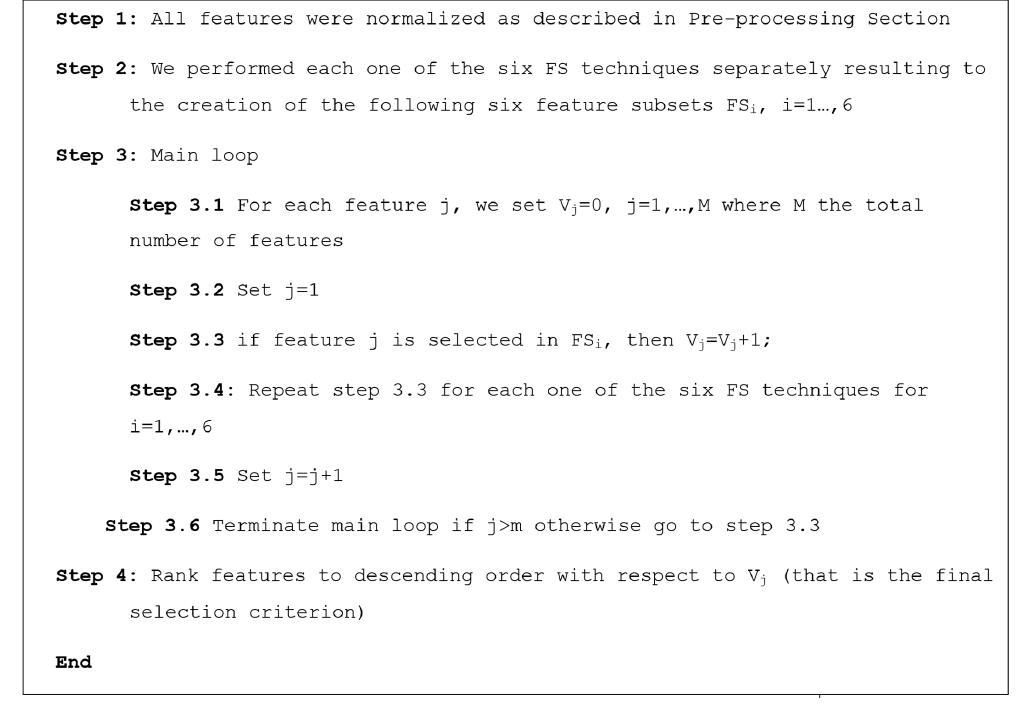
Figure 6. Pseudocode for the implementation of the proposed feature selection (FS).